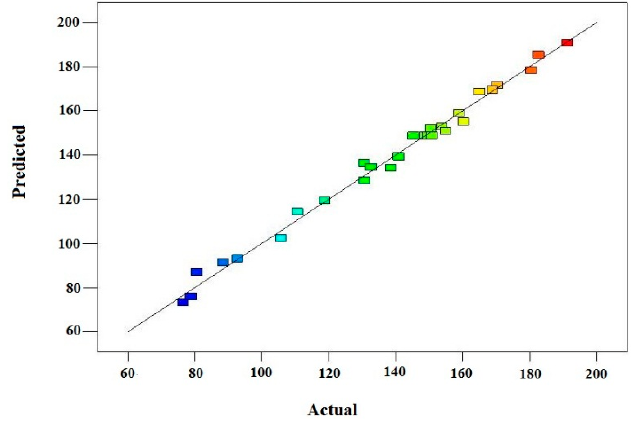
Figure 1. Predicted versus experimental of reducing sugar concentration.